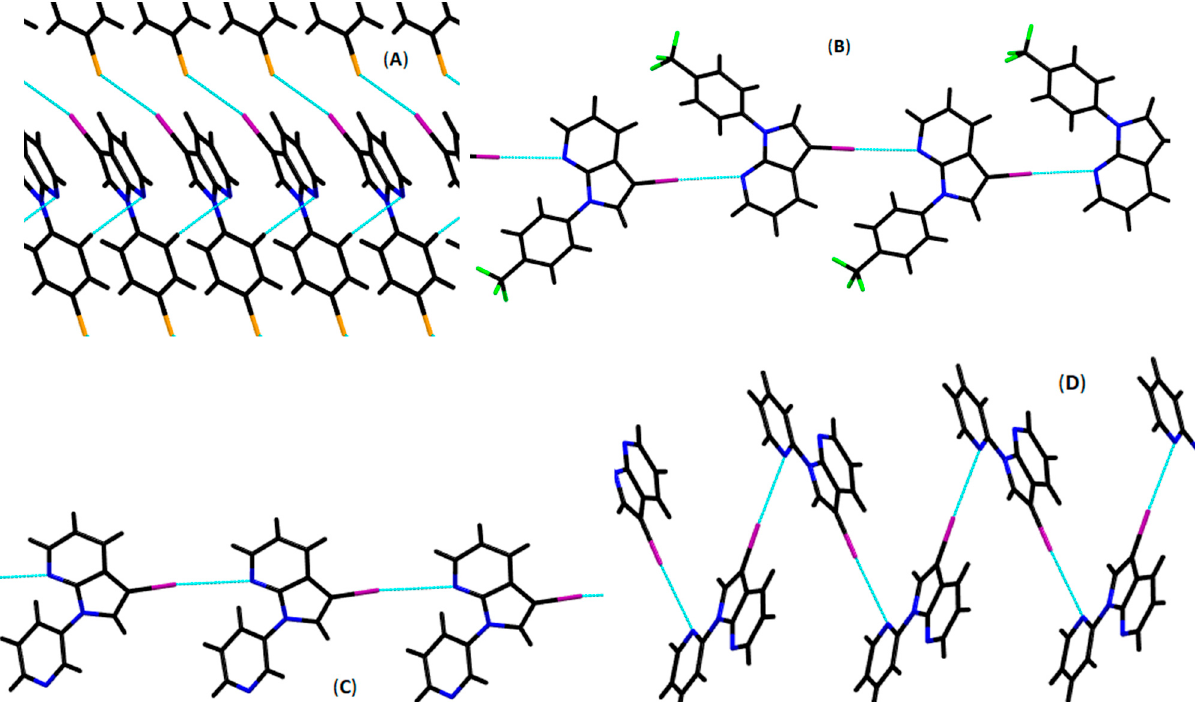
Figure 12. Short-contact network observed for 4c ( A ); halogen bond networks observed for 4e ( B ), 4h ( C ) and 4i ( D ).